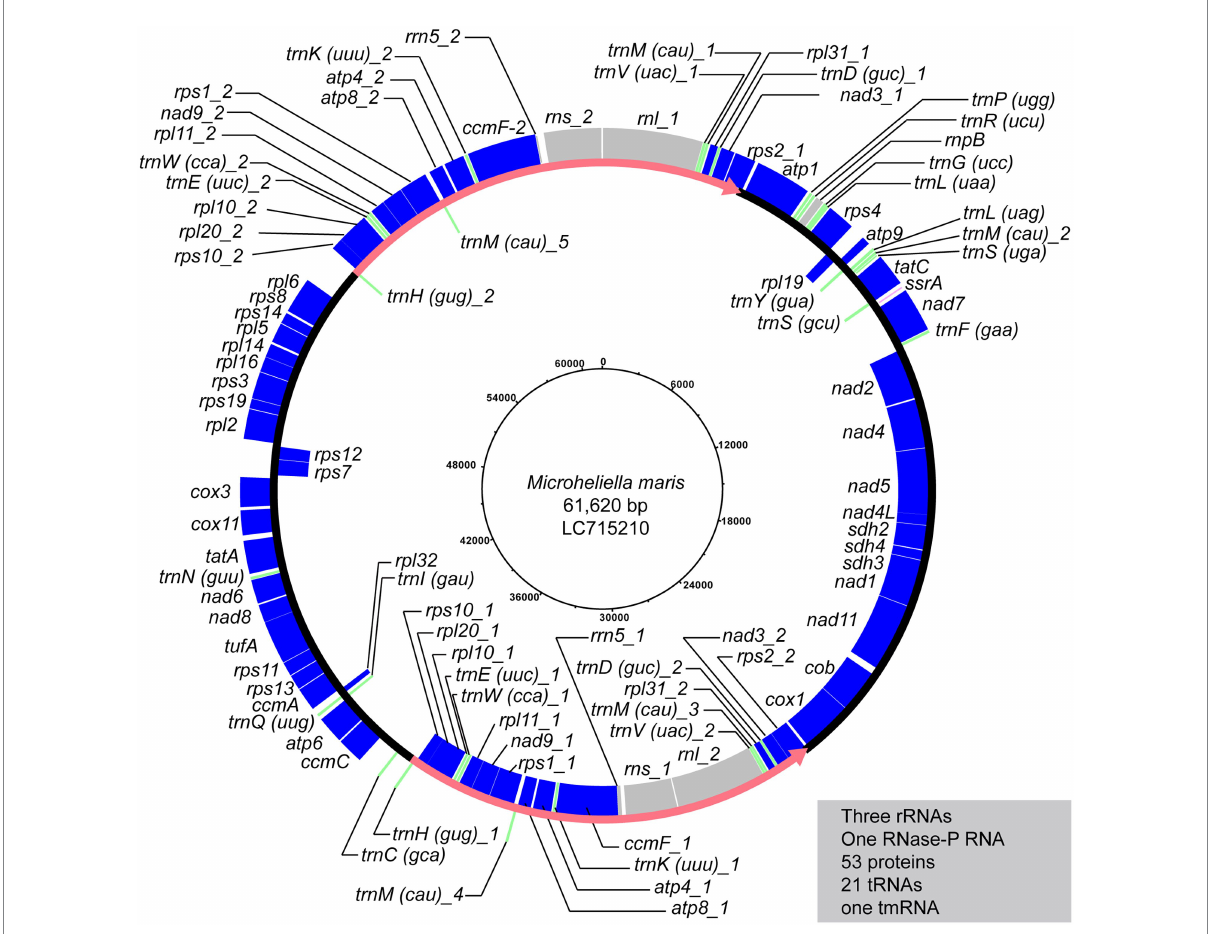
FIGURE 1 The mitochondrial genome map of Microheliella maris. Protein-coding regions are shown in blue. Transfer RNA genes and other structural RNA genes (i.e., rns , rnl , rrn5 , rnpB , and ssrA ) are shown in green and gray, respectively. Pink arrows indicate a pair of inverted